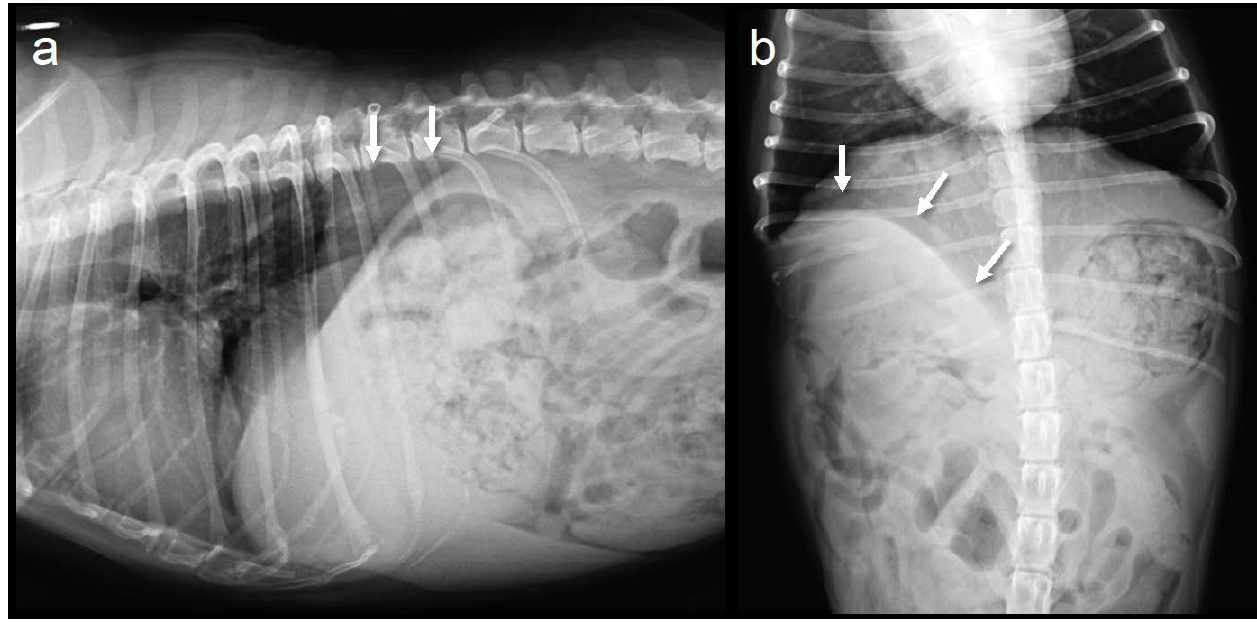
Figure 3. Abdominal radiographs at the 6-month follow-up. The suture line of the diaphragm and thoracic wall is visualized (arrows). ( a ) Lateral view; ( b ) Ventrodorsal view.